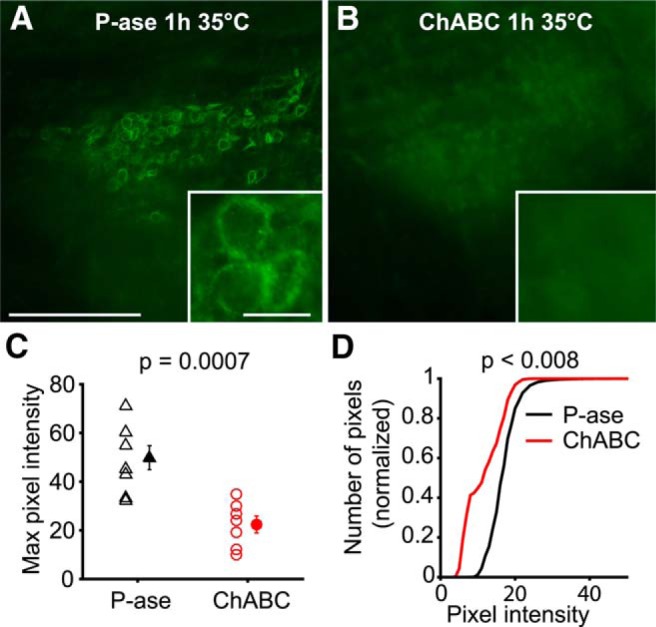
ChABC effectively degrades PNNs in acute brain slices during slice recovery. A, WFA-labeled PNNs are visible surrounding MNTB neurons after P-ase treatment (negative control). Scale bars: 200 μm; inset, 20 μm. B, ChABC-treated slices had reduced PNN labeling. C, Maximum pixel intensities in MNTB were reduced by ChABC (t test, p = 0.0007). Error bars are the mean and SEM. D, Cumulative plot of pixel intensities shows that ChABC-treated MNTB regions have reduced brightness (two-sample Kolmogorov–Smirnov, p < 0.008). Slices were labeled in parallel with the same reagents and imaged with the same microscope settings.